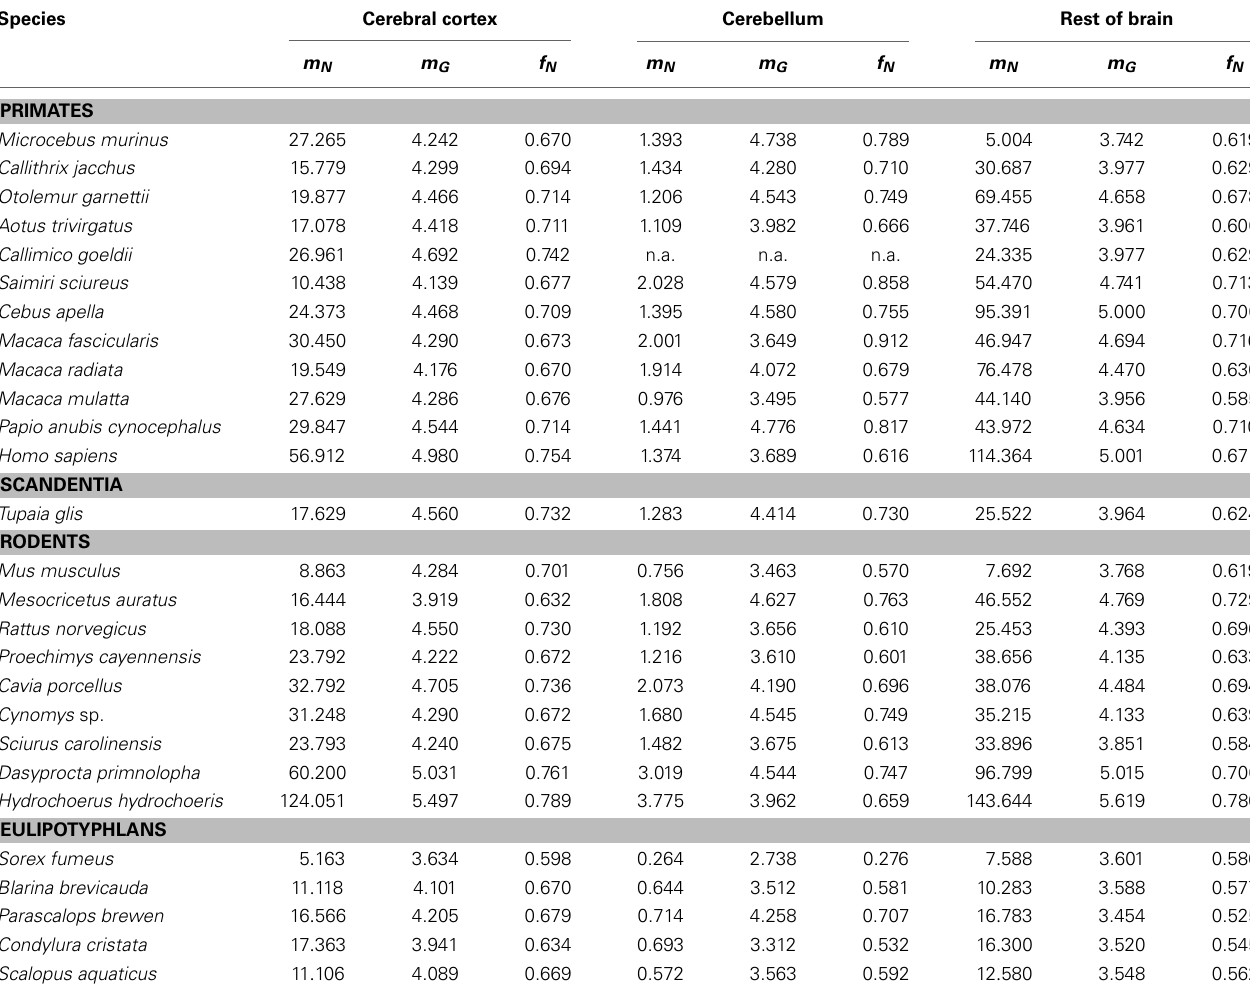
Table 5 | Predicted average cell masses and neuronal mass fraction per